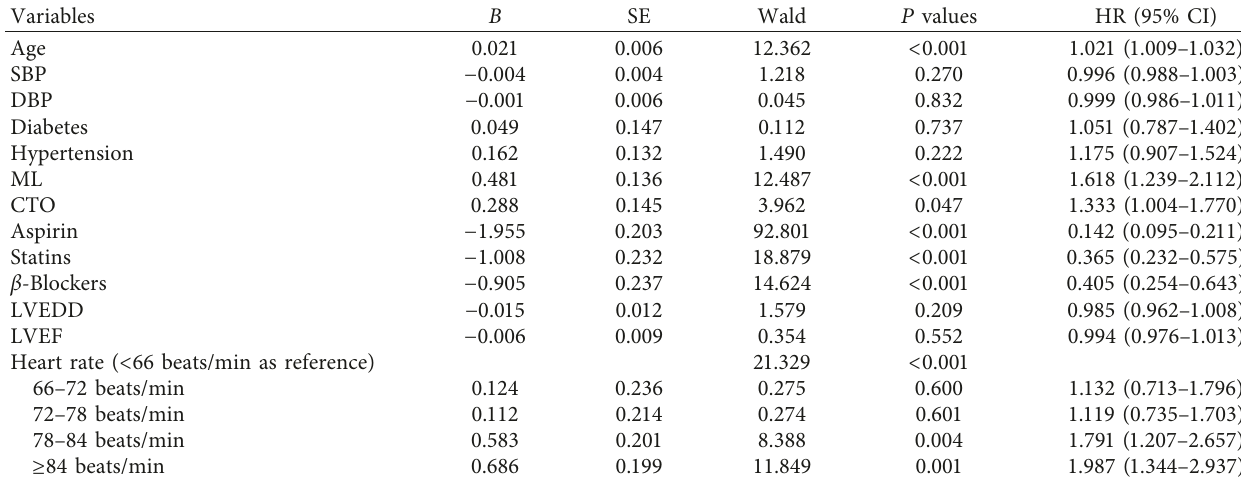
Table 3: Multivariable Cox regression analysis of ACM.